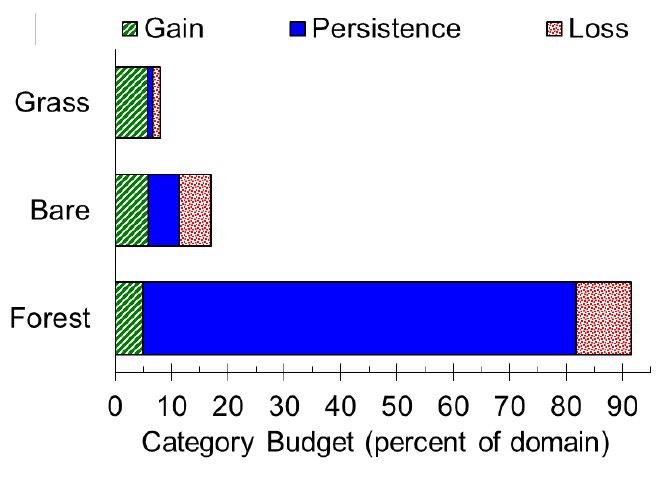
Figure 3. Gain, persistence and loss by category.